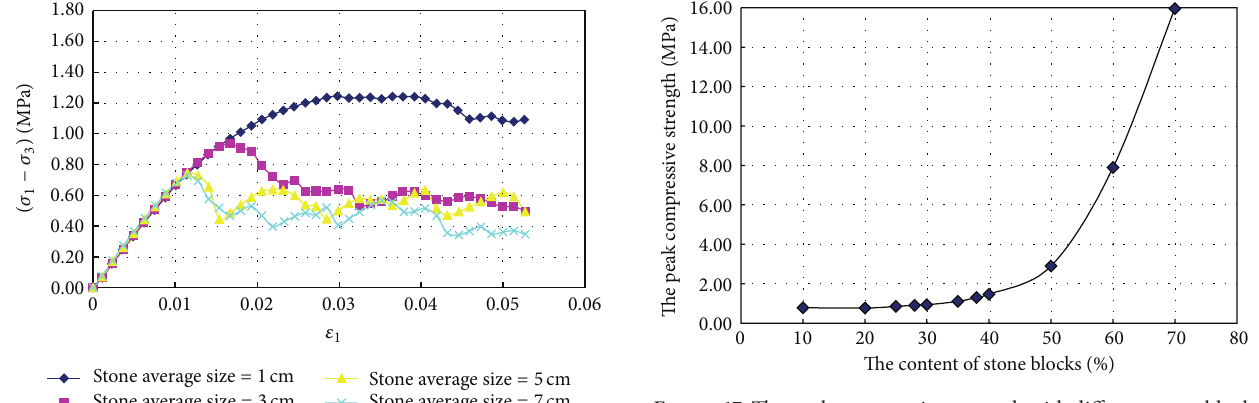
Figure 17: The peak compressive strength with different stone